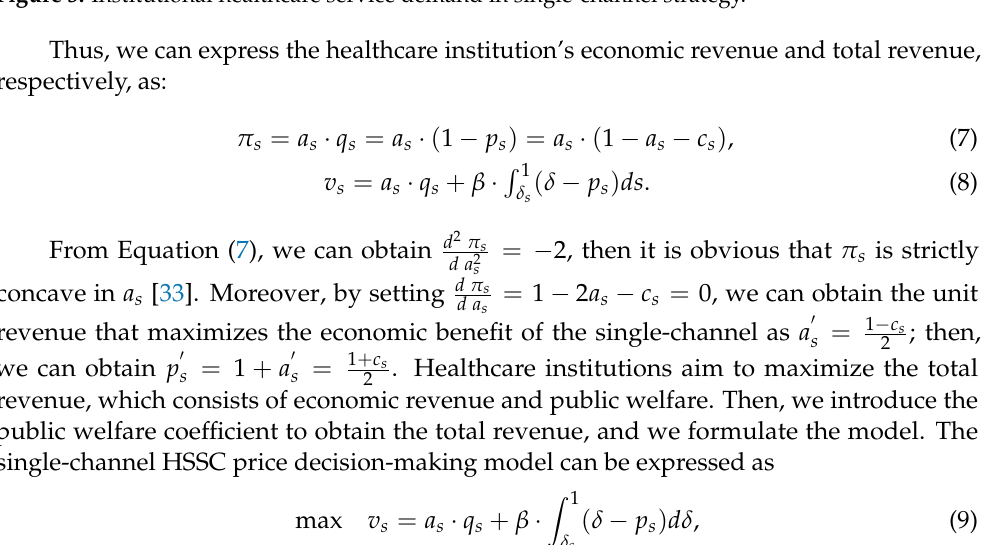
Figure 3. Institutional healthcare service demand in single-channel